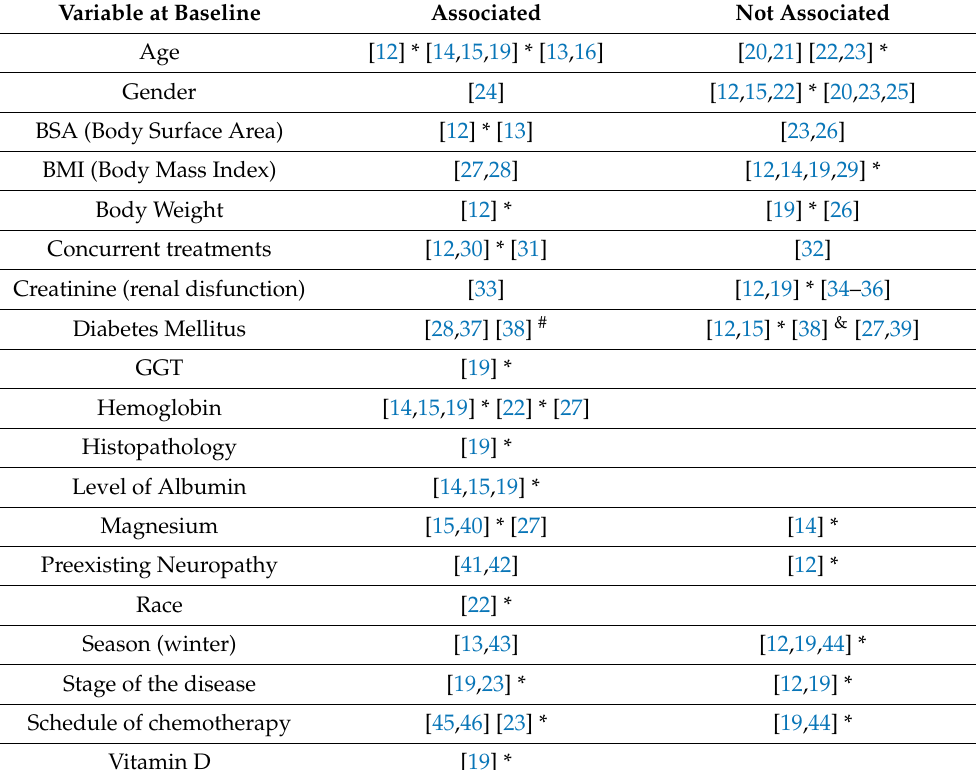
Table 1. Factors investigated that are or not associated with the incidence and severity of oxaliplatin induced peripheral